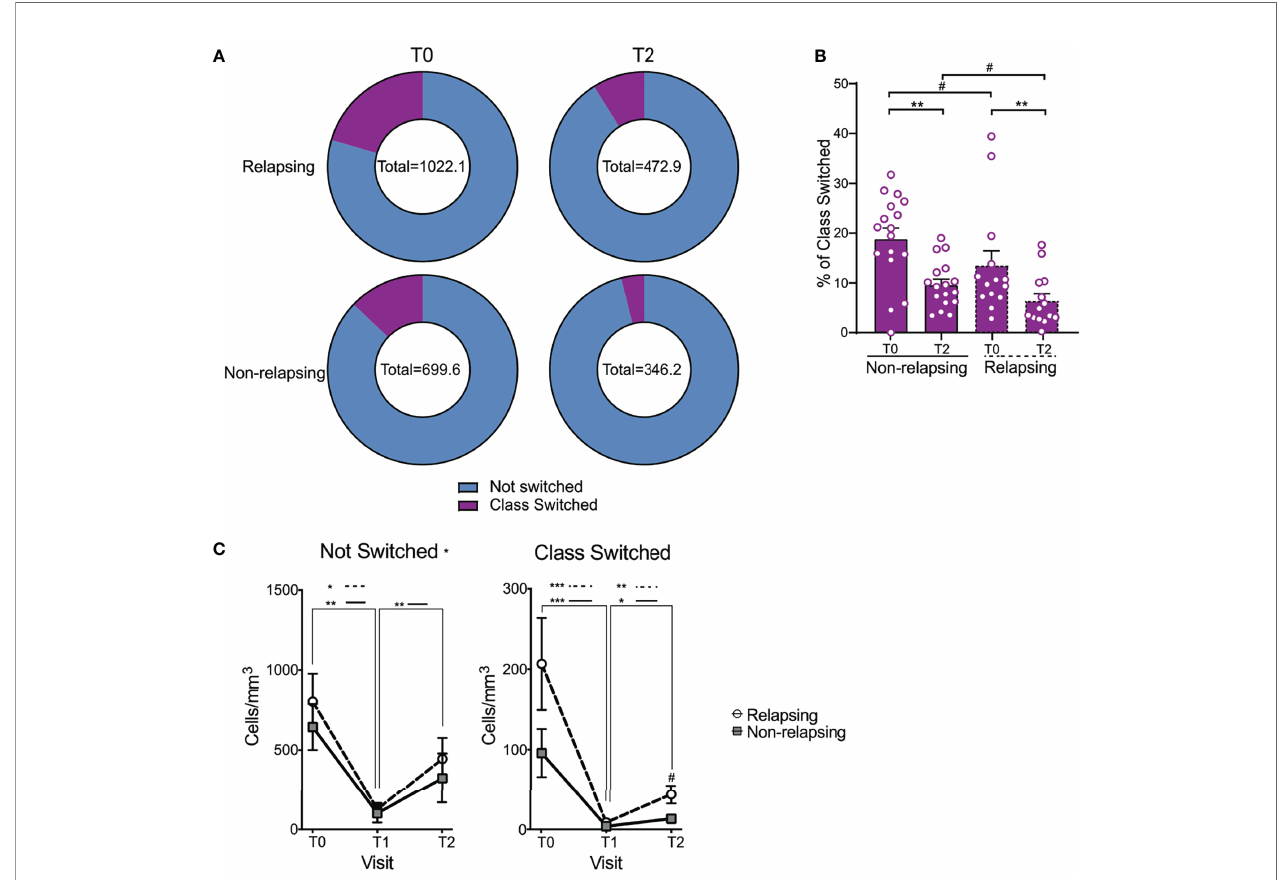
FIGURE 4 | Changes in not switched and class switched B cells after anti-CD20 Ab therapy. (A) Doughnut pie graph of the number of class switched B cells (total = average number of class switched and not-switched cells per sample) before anti-CD20 treatment (T0) and at relapse (or at the same time point after anti-CD-20 therapy in non-relapsing patients) (T2). (B) Bar graph illustrating the percentage of class switched B cells. (C) Changes in absolute numbers of not switched and class switched B cells in relapse and non-relapsing patients at T0, T1 and T2. Comparisons between the relapsing and non-relapsing groups at the same timepoint # p < 0.05. Comparisons between different timepoints *p < 0.05, **p < 0.01, ***p < 0.001. Two-way ANOVA corrected for multiple comparisons. Bar plots and data points depict mean ±